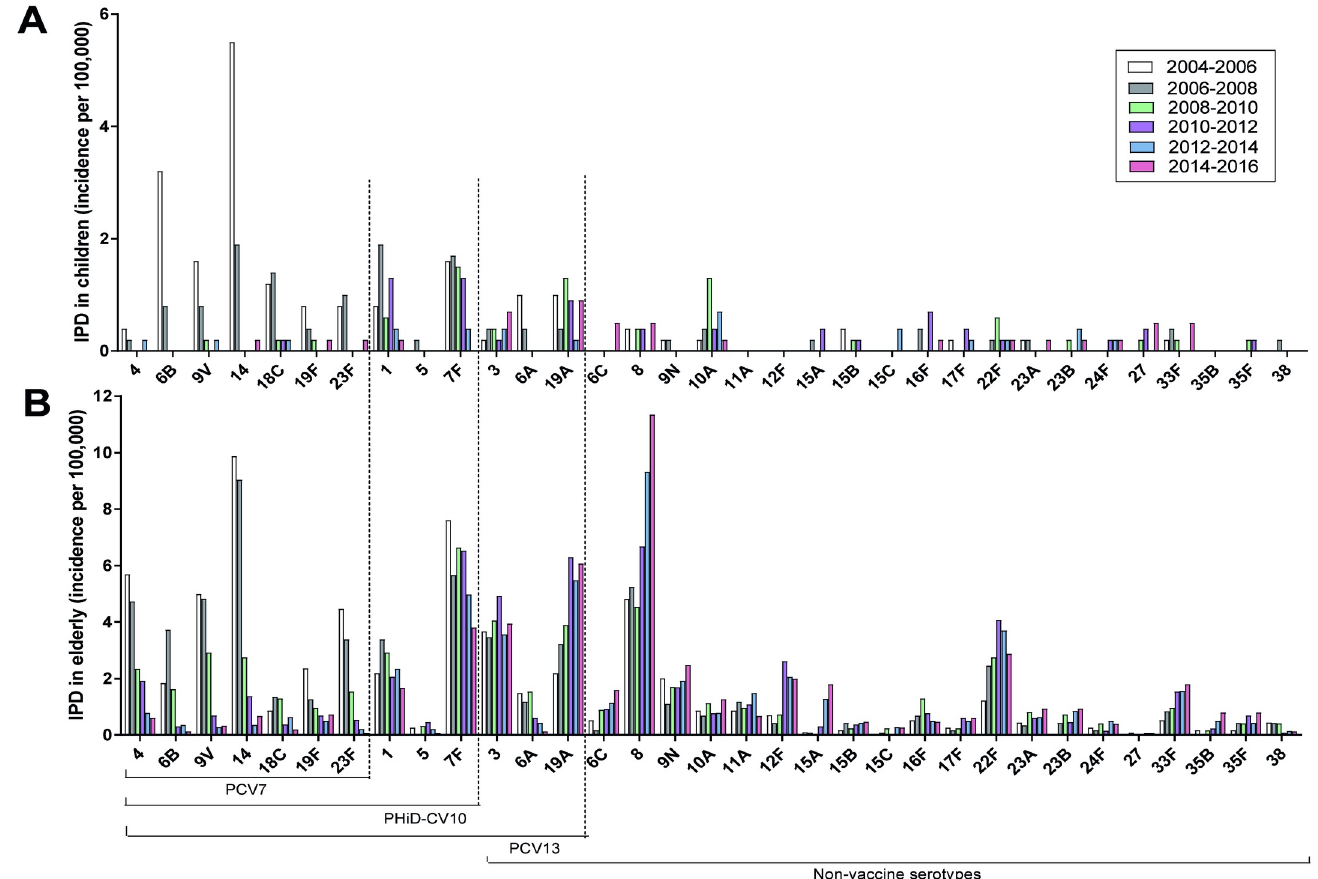
Fig 4. Serotype distribution of IPD in children ( < 5 years) (A) and older adults ( > 65 years) (B). Incidence of IPD was calculated per two epidemiological years. The first bar (June 2004- June 2006) depicts the IPD incidence in the years before implementation of PCV. The following five bars depict IPD incidence as